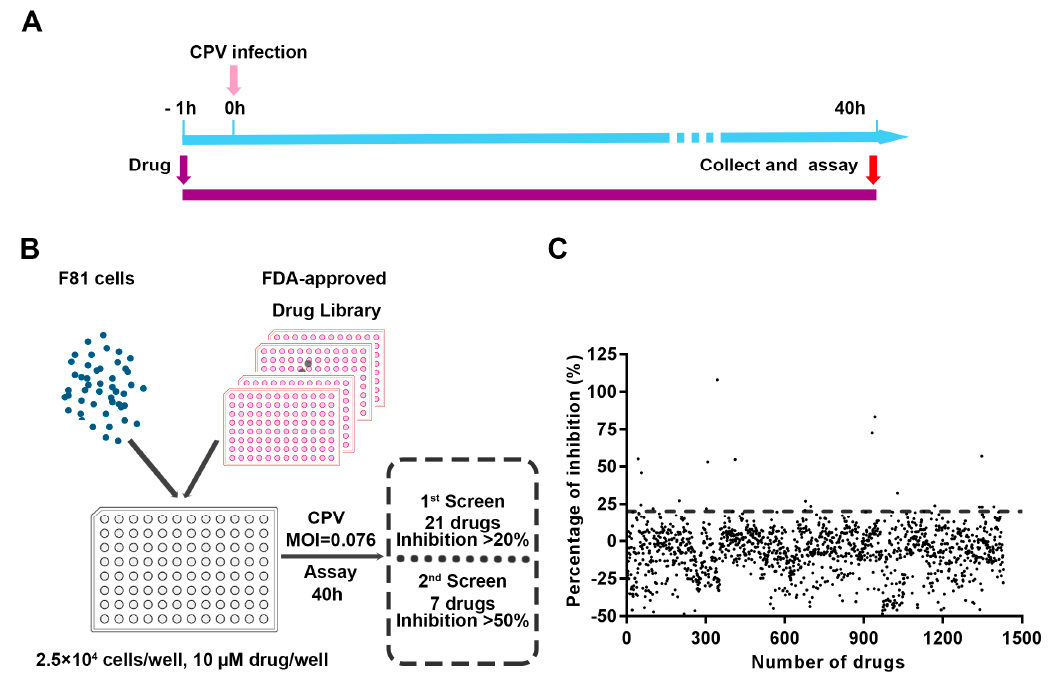
Figure 1. Screening of the FDA-approved compound library for inhibitors of CPV replication. ( A ) Experimental timeline of drug treatment and CPV infection. F81 cells were seeded in 96-well plates and pretreated with 10 µ M drugs for 1 h before CPV infection, then cell viability was examined using the TransDetect ® Cell Counting Kit at 40 h postinfection. ( B ) Flow chart of drug screen using CPE-based assay. Briefly, F81 cells per well were pretreated with 10 µ M drugs for 1 h, and then infected with 0.076 MOI CPV, cell viability was detected at 40 h postinfection as described above, antiviral inhibitors against CPV were determined according to the percentage CPE inhibition. Twenty-one drugs showing > 20% CPE inhibition from the primary screen were used for a second round of screening, and seven drugs with percentage inhibition > 50% were further identified. ( C ) Scatter plot of percentage CPE inhibition results for 1430 FDA-approved drugs, numbers in X axis mean the species of the tested drugs, each number corresponds to a specific drug, and the order is the same as that provided in the manual of the FDA-approved drug library, each dot shows the mean percentage CPE inhibition in the presence of 10 µ M tested drug.